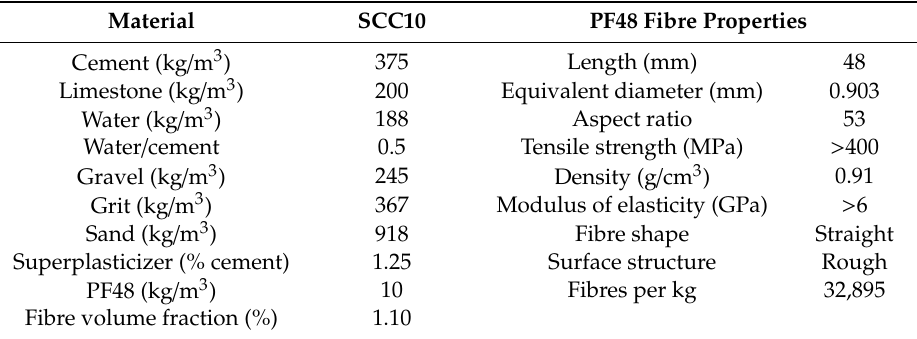
Table 1. Concrete composition and fibre